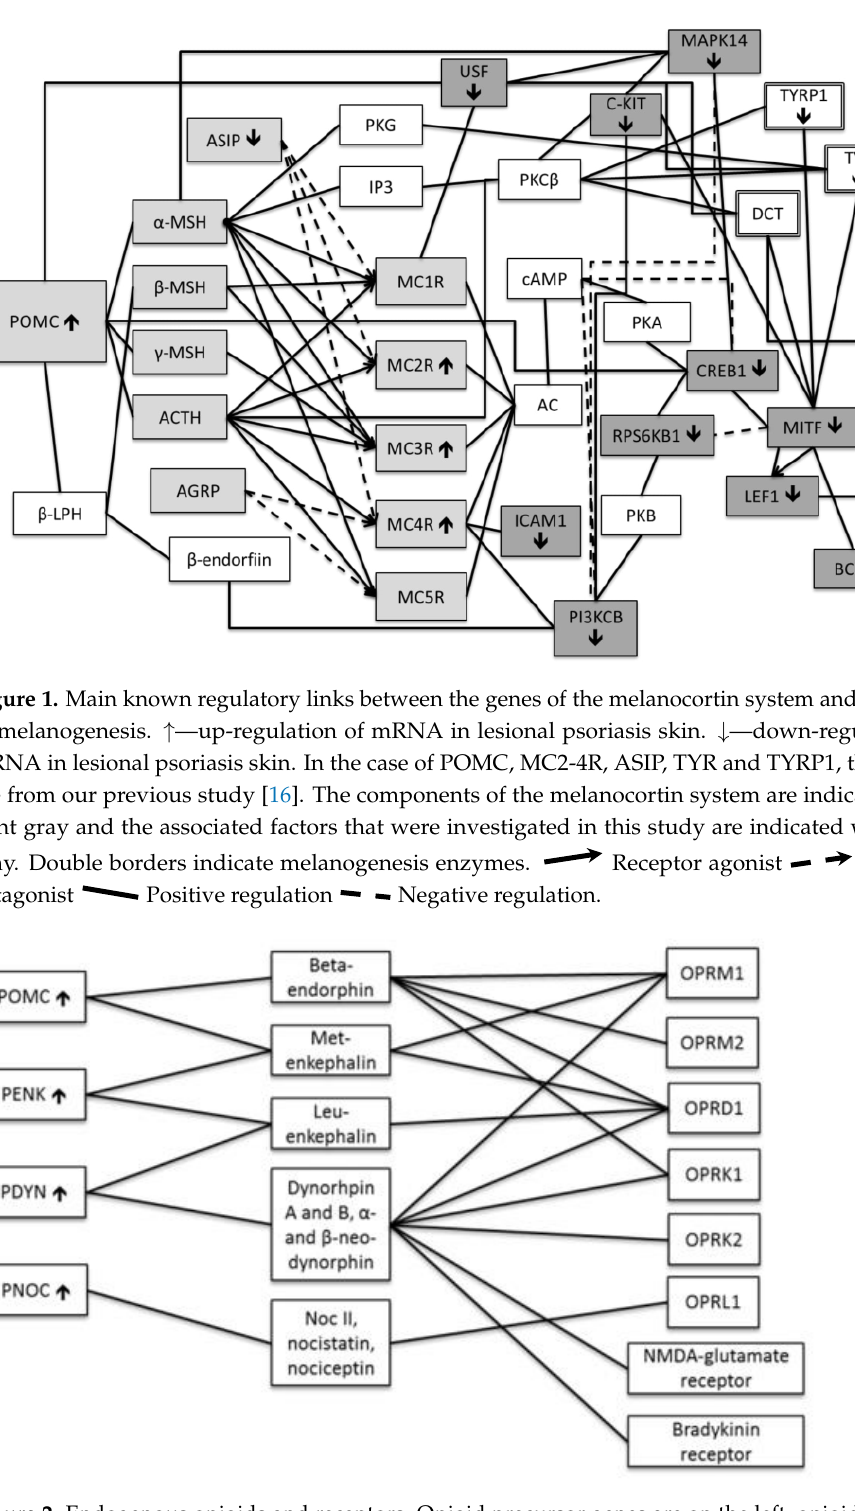
Figure 2. Endogenous opioids and receptors. Opioid precursor genes are on the left, opioid peptides in the middle and their receptors on the right. POMC, proopiomelanocortin; PENK, proenkephalin; PDYN, prodynorphin; PNOC, prepronociceptin; OPRM1 and -2, opioid receptor mu 1 and 2; OPRD1, opioid receptor delta 1; OPRK1 and -2, opioid receptor kappa 1 and 2; OPRL1, opioid re- ceptor like-1; NMDA-glutamate receptor, N-methyl-D-aspartic acid-glutamate receptor. ↑ — upreg- ulation of mRNA in lesional psoriasis skin. In the case of POMC, the result is from our previous study [16]. The up-regulation of PENK was detected in lesional skin compared to non-lesional pso- riasis skin. 2. Results 2.1. mRNA Expression in Lesional, Non-Lesional, and Control Skin The mRNA expression levels of twelve genes related to intracellular signal transduc- tion between the melanocortin system and enzymes of melanogenesis were measured to- gether with five genes of endogenous opioid system (Figures 1‒3).